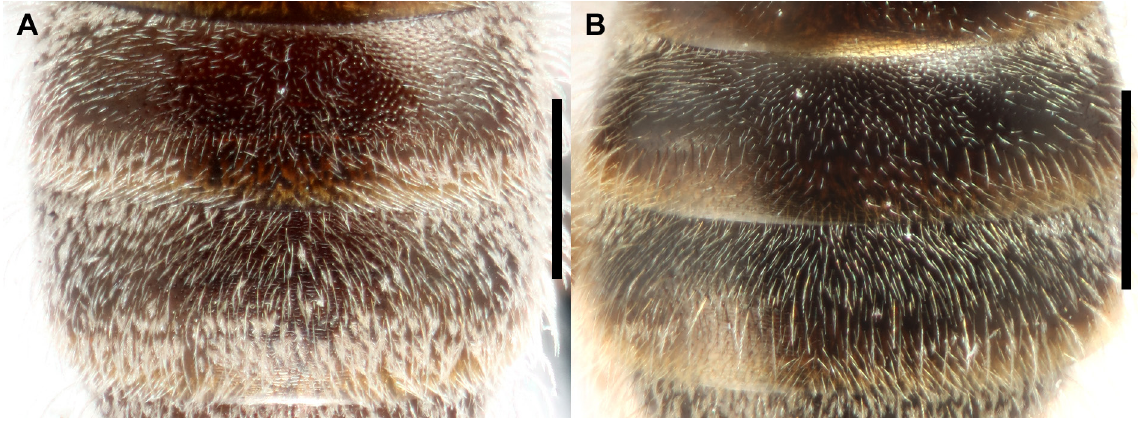
Fig. 86. T2–T3. A . Lasioglossum coactus (Cresson, 1872), ♀, with complete subapical band of tomentum on T3 and deep and dense punctures on disc of T2 contrasting with sparsely punctate apical rim. B . L. angelicum sp. nov., ♀, T3 without complete subapical band of tomentum and fine T2 punctures not contrasting across premarginal line. Scale bars = 0.5